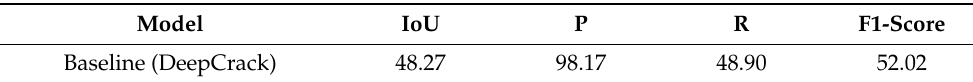
Table 7. Performance (mean values—%) of the pretrained baseline model on the test set after 5-fold